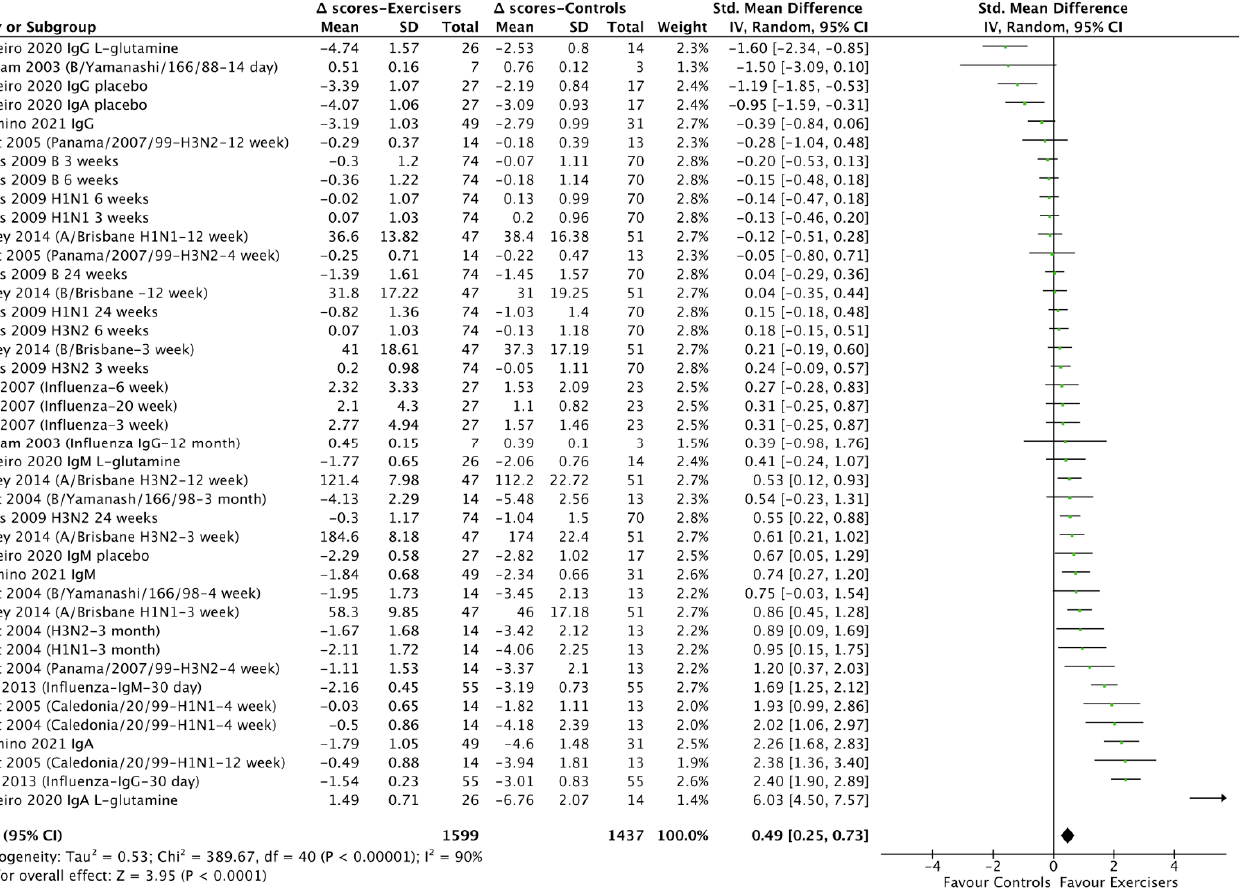
Figure 1. Forest plot of the effect of chronic exercise on influenza vaccine antibodies. Δ scores: post intervention–baseline; SD: standard deviation; 95% CI: 95% confidence interval.